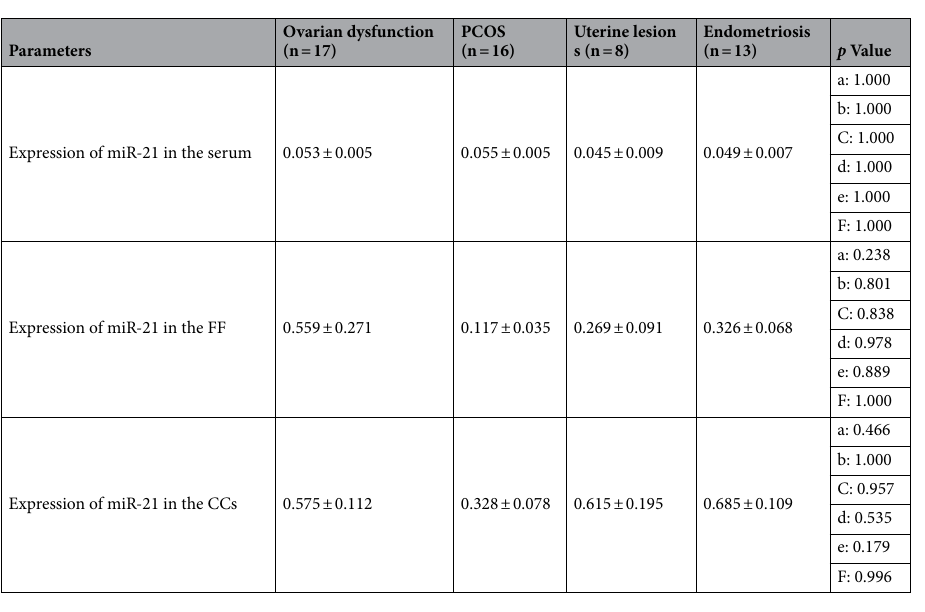
Table 3. Comparison of miR-21 expression in four subgroups of the case group. Relative miR-21 expression was compared in the serum, FF, and CCs samples in the four subgroups of the case group (ovarian dysfunction, PCOS, uterine lesions, and endometriosis). Relative expression of miR-21 was not significant between all groups based on the Anova test ( p < 0.05). a: p value between ovarian dysfunction and PCOS groups, b: p value between ovarian dysfunction and Uterine lesions groups, c: p value between ovarian dysfunction and Endometriosis groups, d: p value between PCOS and Uterine lesions groups, e: p value between PCOS and Endometriosis groups, f: p value between Uterine lesions and Endometriosis groups. The results are presented as the mean ± SEM. FF follicular fluid, CCs cumulus cells.